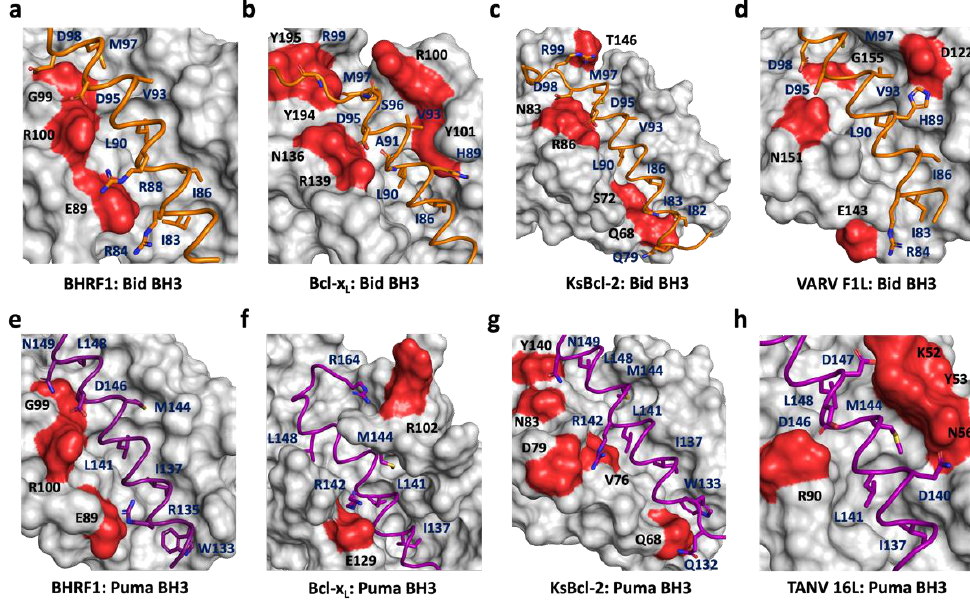
Figure 4. Comparison of BHRF1 – Bid BH3 and Puma BH3 interaction sites with other closely related Bcl-2 – BH3 complexes. ( a ) The BHRF1 surface and BH3 interaction sites are shown in gray and red respectively, whilst the Bid BH3 ribbon is shown in orange. ( b ) Human Bcl-x L – Bid BH3; ( c ) KSHV KsBcl-2 – Bid BH3; ( d ) VARV F1L – Bid BH3; ( e ) BHRF1 – Puma BH3; ( f ) human Bcl-x L – Puma BH3; ( g ) KSHV KsBcl-2 – Puma BH3; ( h ) tanapoxvirus TANV16L – Puma BH3. The interaction formed by Bcl-2 – BH3 residues and hydrophobic residues in the ligand-binding groove are labeled. Only residues located in the binding pockets are shown. Polar residues close to the BH3 ligand on the Bcl-2 protein are shown in red. The color schemes for the BH3 peptide and views in ( b – h ) are as in Figure 1.